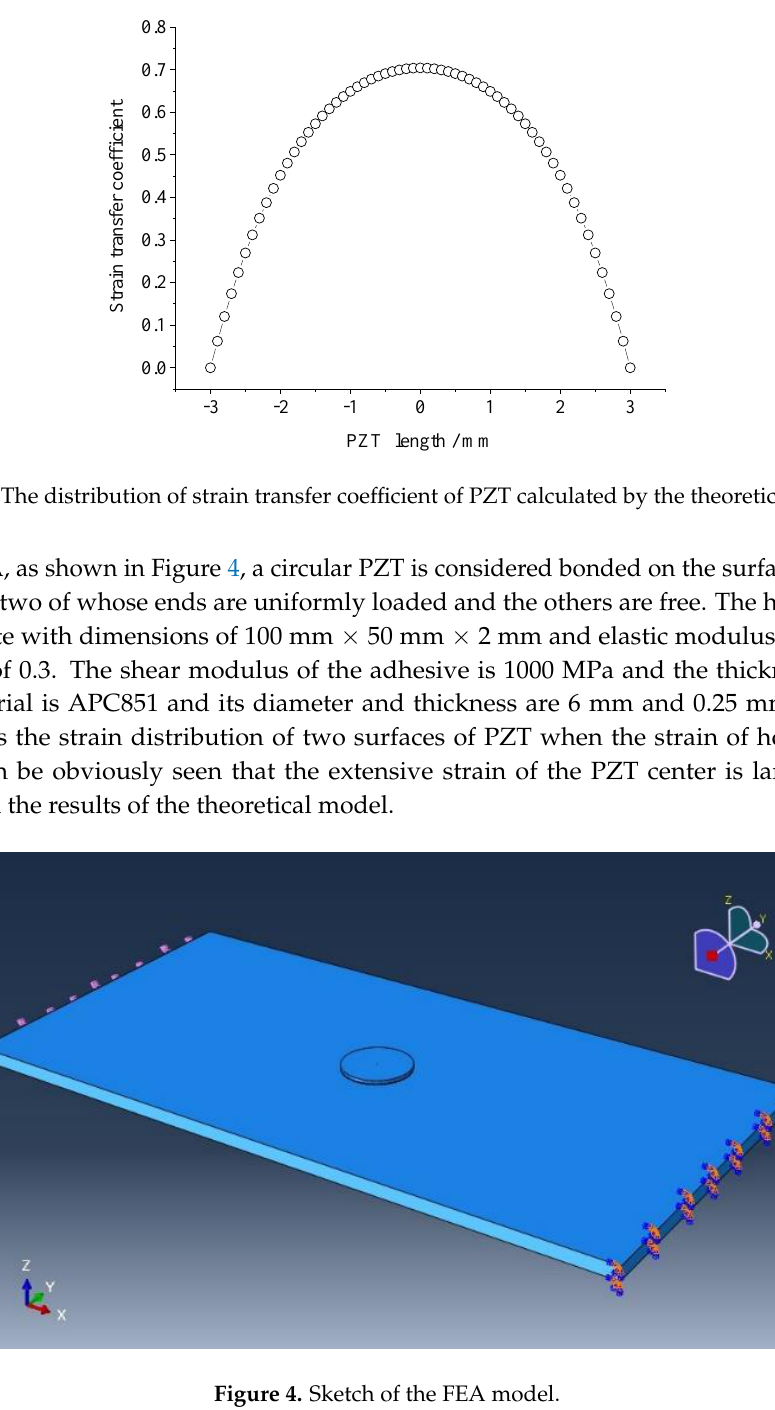
Figure 4. Sketch of the FEA model.